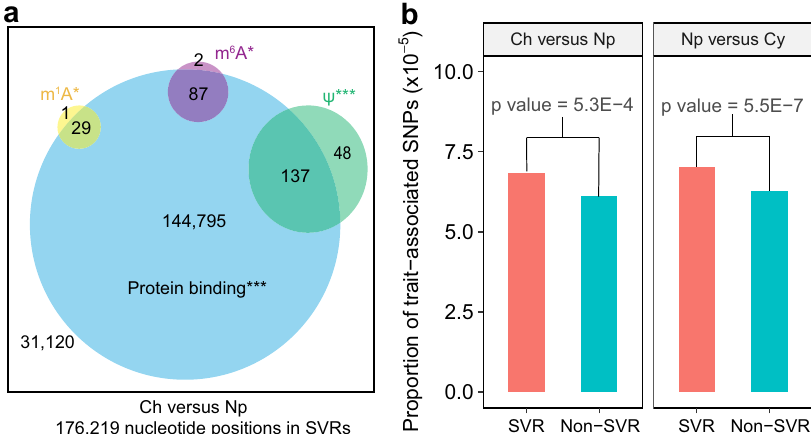
Ch versus Np 176,219 nucleotide positions in SVRs Fig. 4 Application of DiffScan to explore the roles of RNA structural variation. a in regulating mRNA abundance and b shaping human traits in an icSHAPE dataset mapping RNA structure across human cellular compartments. Ch chromatin, Np nucleoplasm, Cy cytoplasm. a Predicted SVRs between Ch and Np were enriched with protein binding sites and RNA modi fi cation sites. * p value (one-sided Fisher ’ s exact test) < 0.05, *** p value < 1e-6. P values of enrichment: m 1 A = 5.85e-3, m 6 A = 4.77e-2, ψ = 2.87e-14, protein binding < 2.2e-16. b Enrichment of trait-associated SNPs in predicted SVRs. Proportion of trait-associated SNPs in SVR and non-SVR positions are plotted. P values are calculated by one-sided Fisher ’ s exact